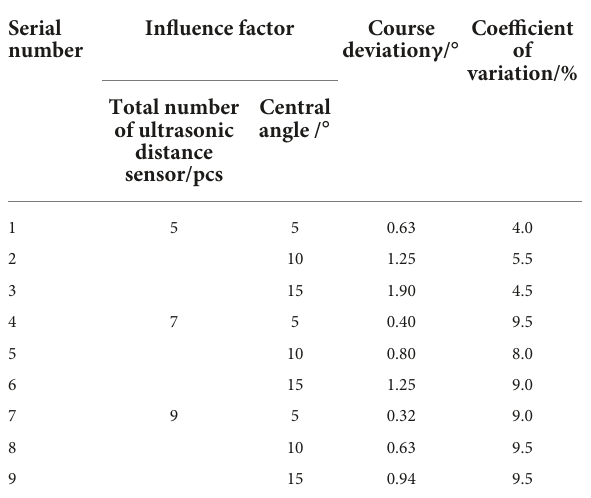
TABLE 4 Multi-factor coupling affects the accuracy of heading deviation